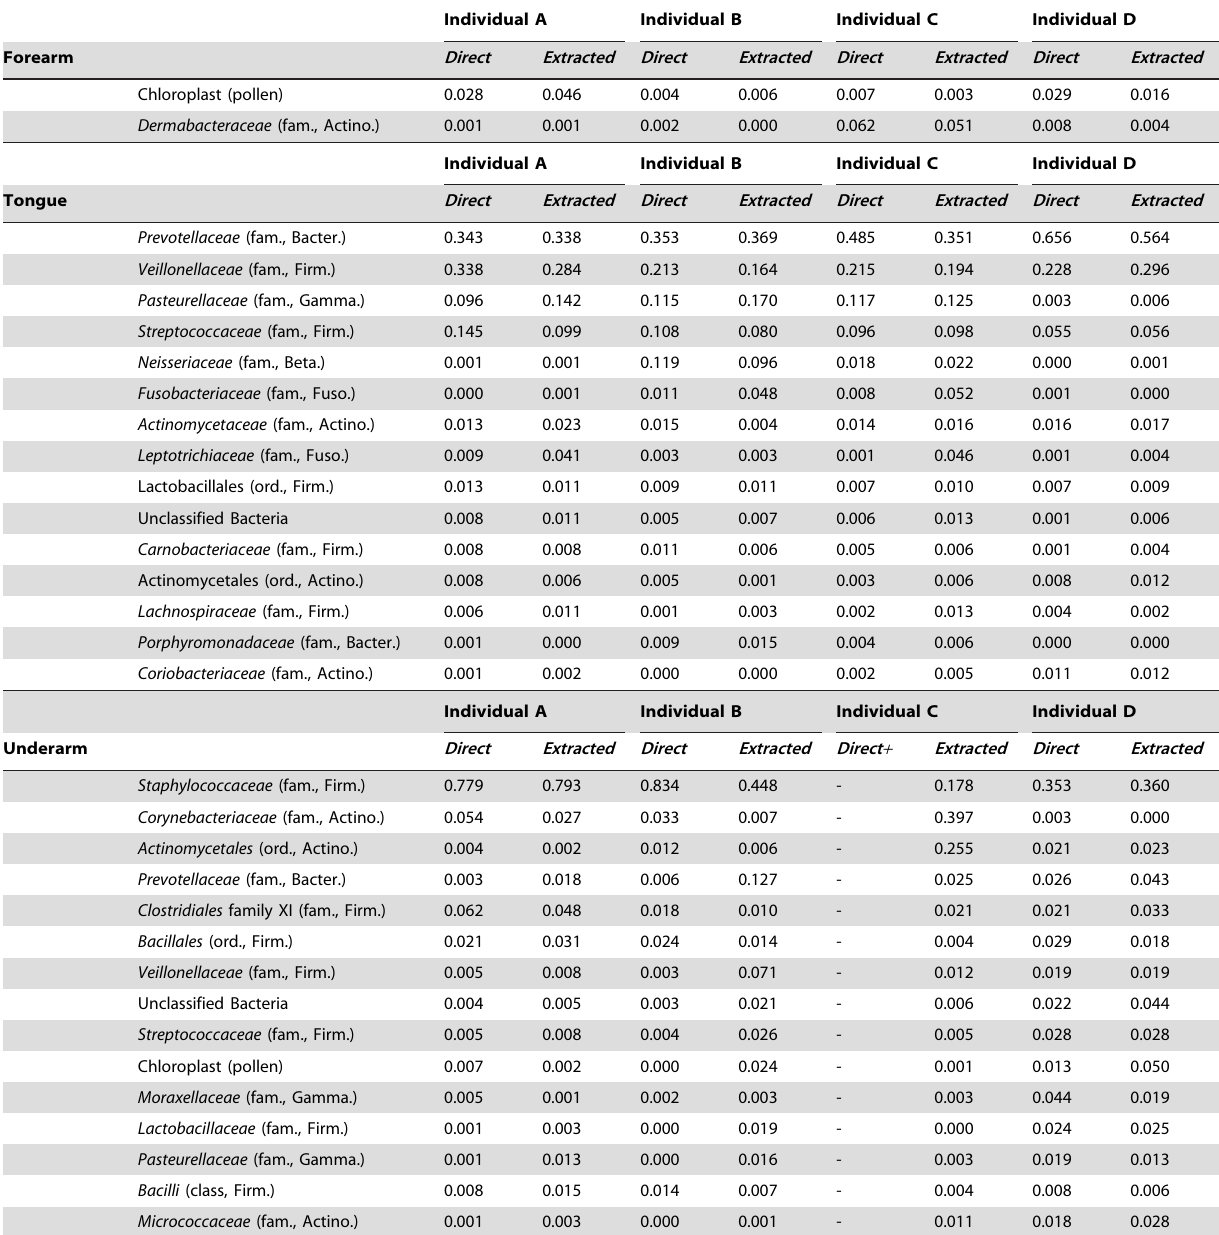
Individual A Individual B Individual C Individual